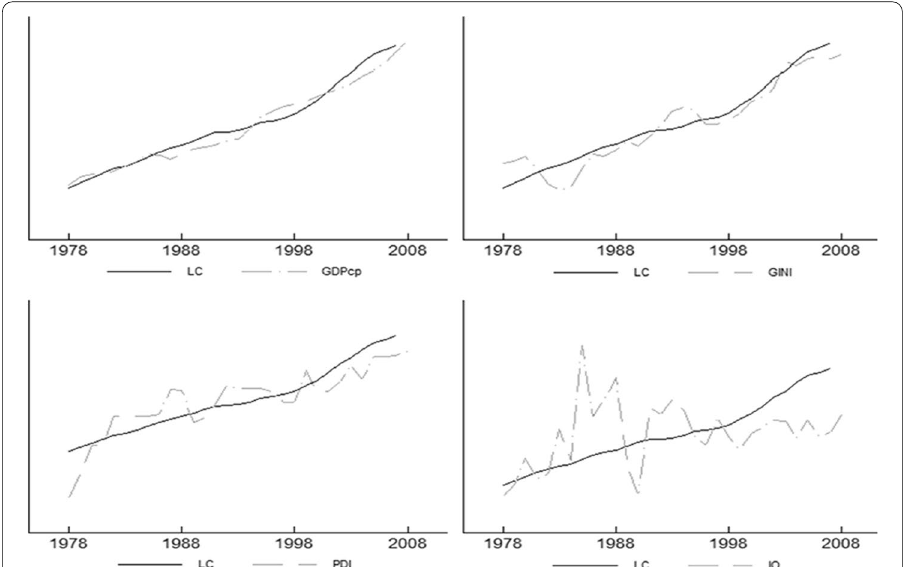
Fig. 1 The trends of social class concern by macroeconomics, income inequality, political participation, and public opinion Note : (1) LC: Literary References to Class; (2)GDP: Gross Domestic Product (3) GINI: Gini